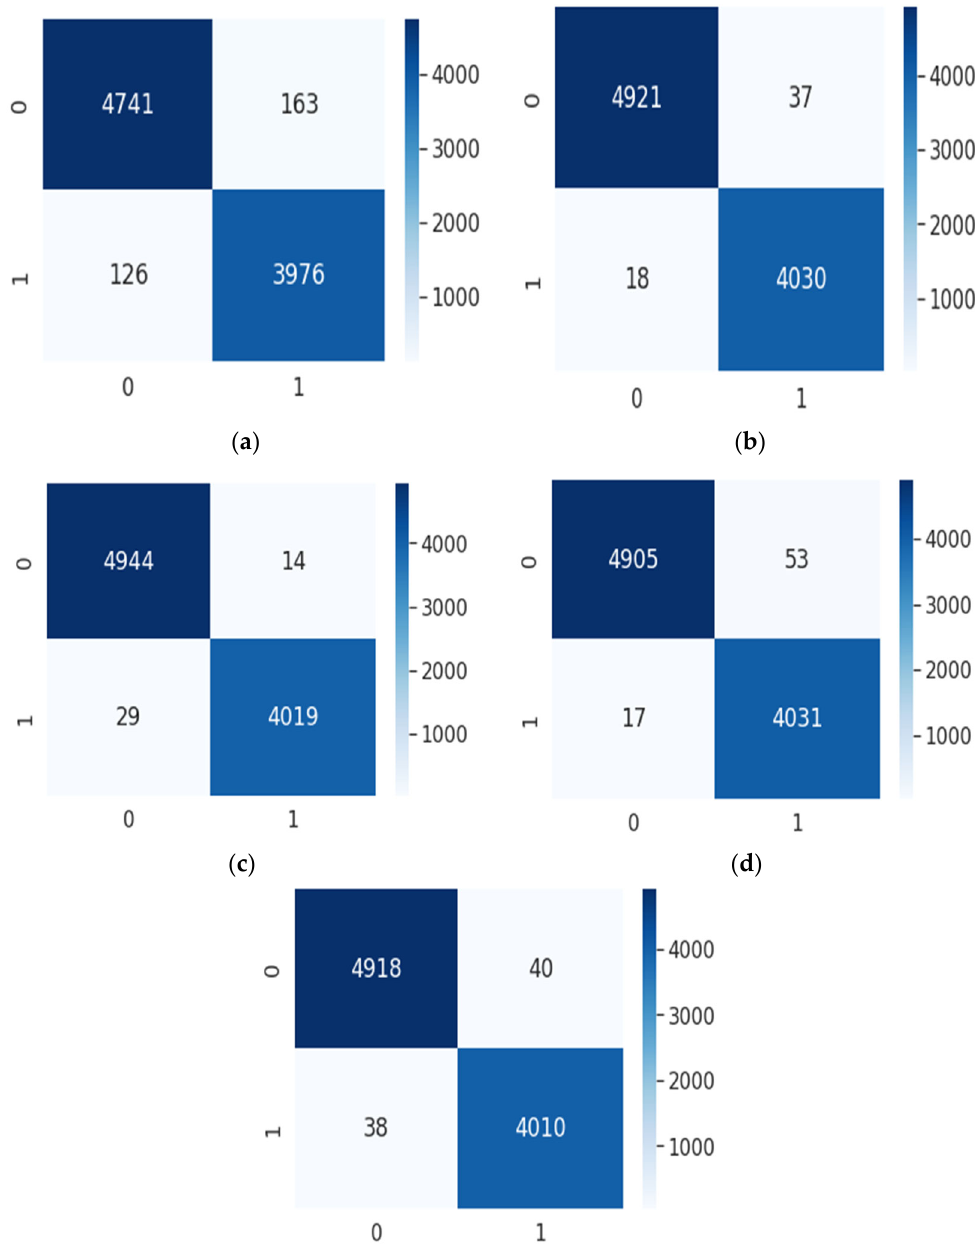
Figure 10. The proposed model’s confusion matrixes for the different numbers of scales: ( a ) single scale, ( b ) two scales, ( c ) three scales, ( d ) four scales, and ( e ) five scales.